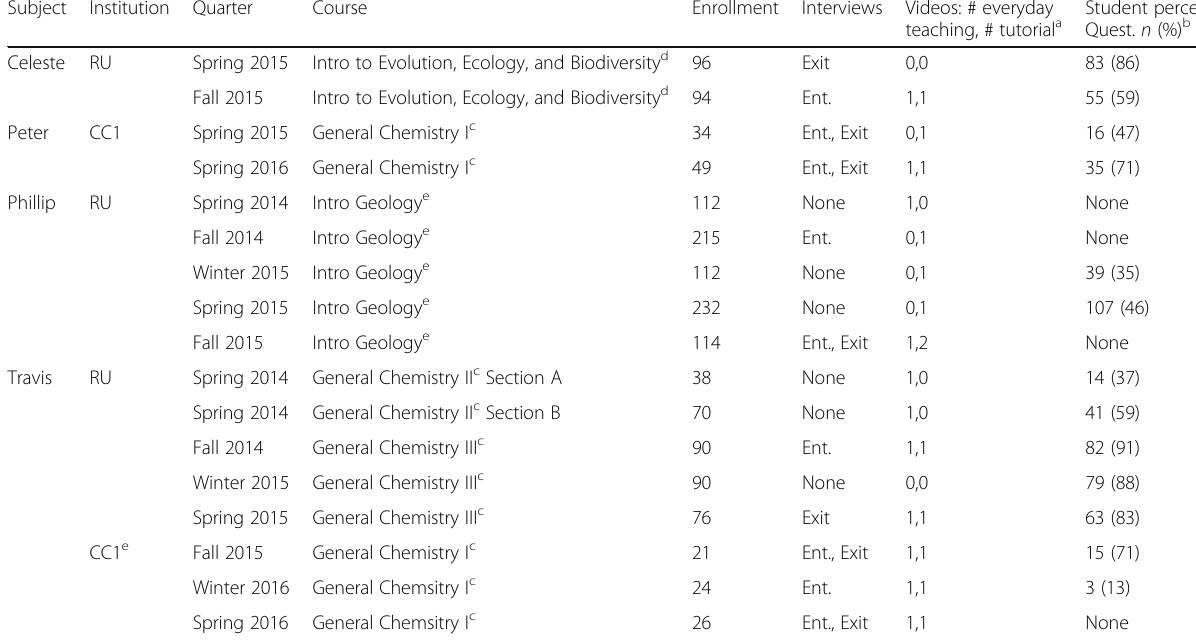
Table 3 Summary of data collected from each case study subject, and information from the courses in which they were collected, during the seven academic quarters of data